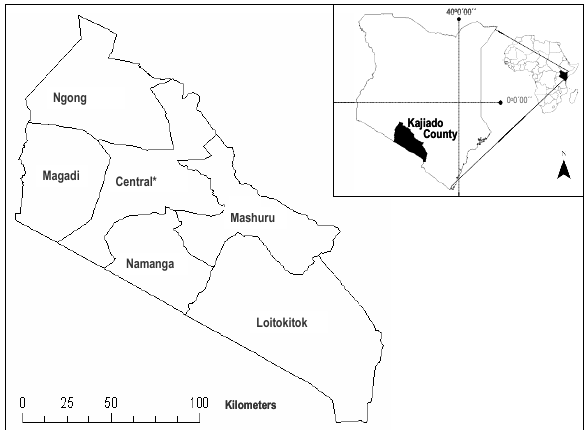
Fig. 1. Kajiado County, Kenya, showing administrative divisions *Central Division has since been sub-divided. Inset: Map of Kenya and Africa showing the location of Kajiado County in the context of the broader region (Source: Mwangi,